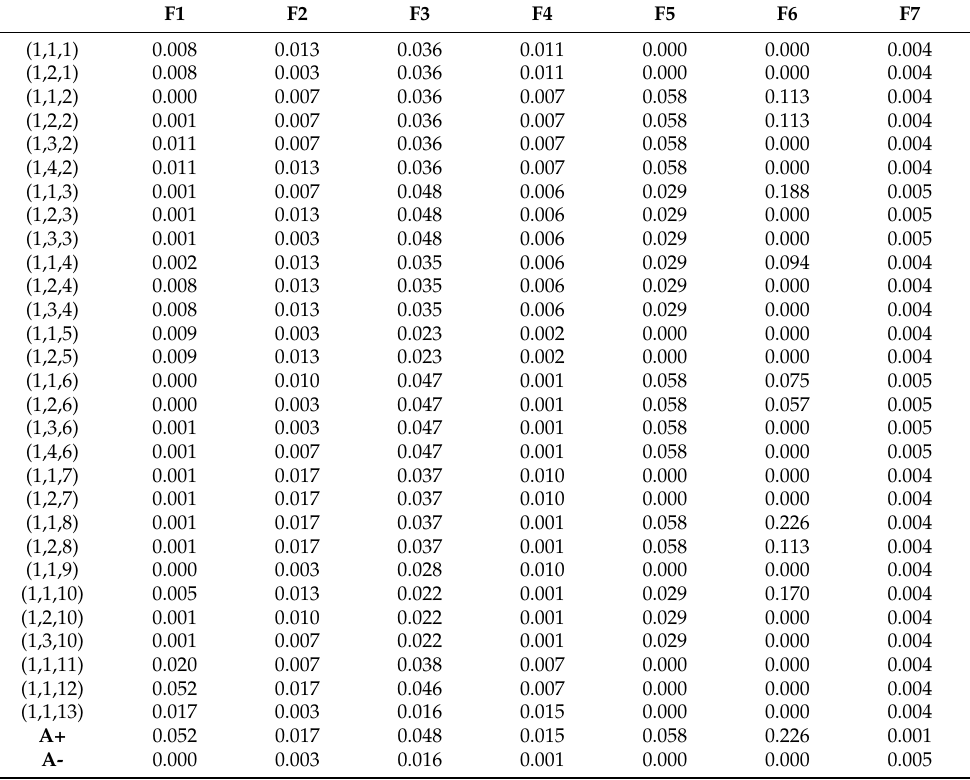
Table A9. The weighted normalized decision matrix V in TOPSIS application—1st